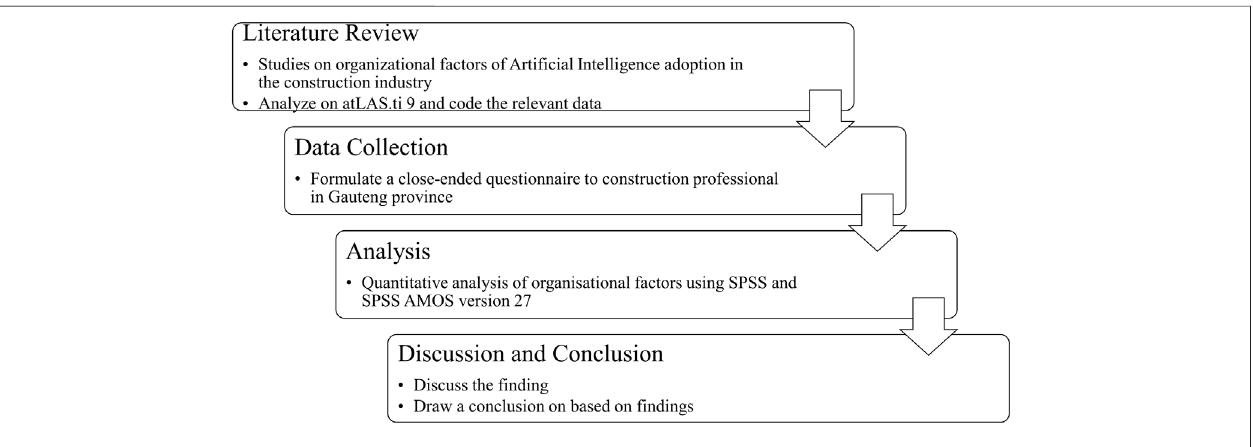
FIGURE 1 | The research process of the